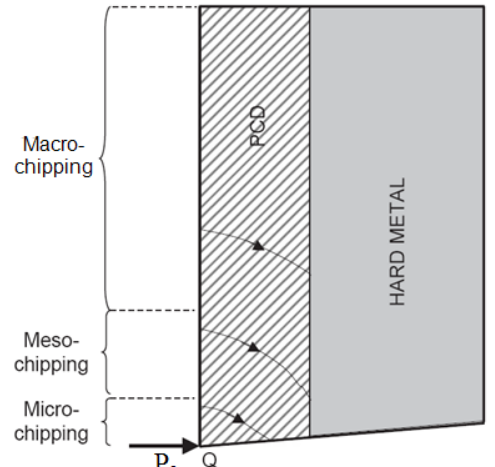
Figure 2: Sketch of a PCD bit used in cutting tools [10]. The critical impact load is denoted by Pc and different possible failure modes ranging from micro- to macro-chipping are sketched.